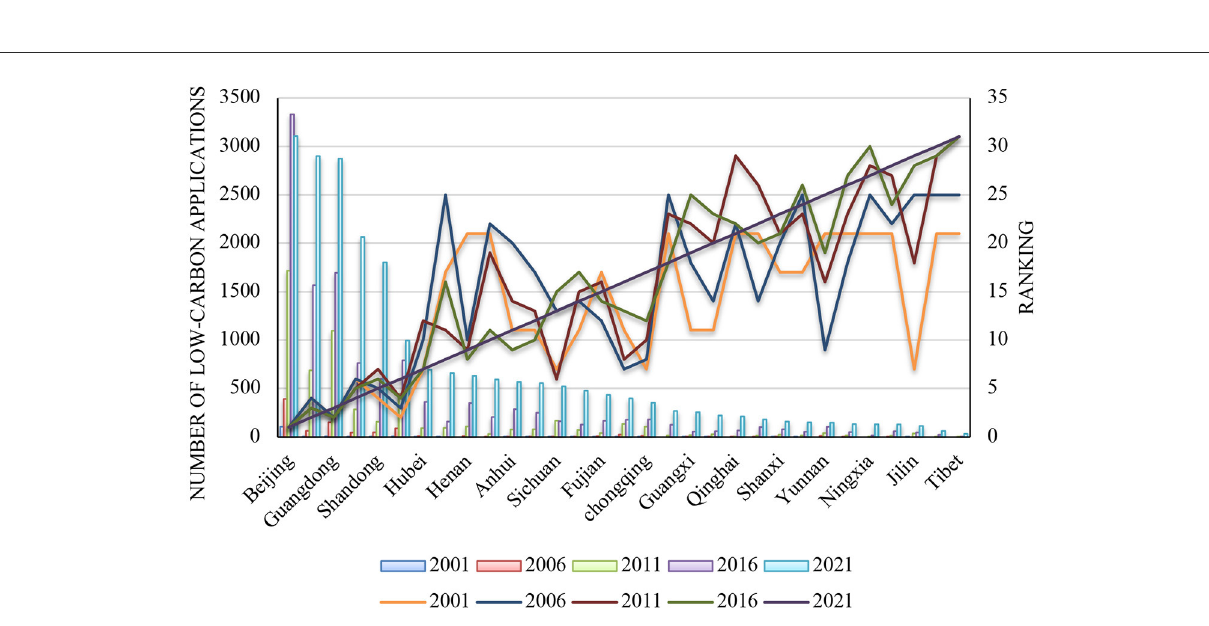
FIGURE2 Number and ranking of low-carbon patent applications of the 31 provinces/municipalities.